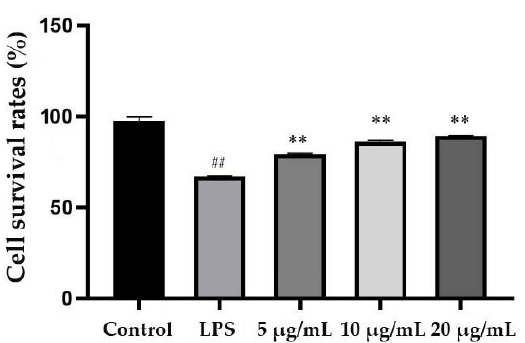
Figure 4. Influence of EEP ‐ B on LPS ‐ stimulated MACE growth. ## means extremely significant difference ( p < 0.01) between LPS ‐ stimulated group and control and ** means extremely significant difference ( p < 0.01) between propolis treatment group and LPS ‐ stimulated group.